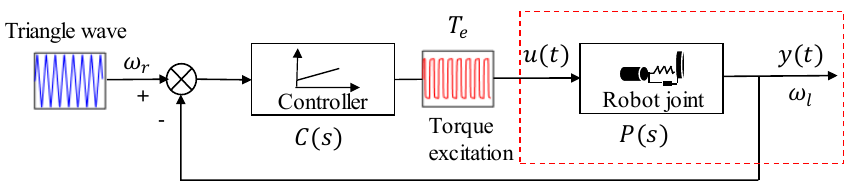
Figure 3. Block diagram of closed loop speed control of robot.